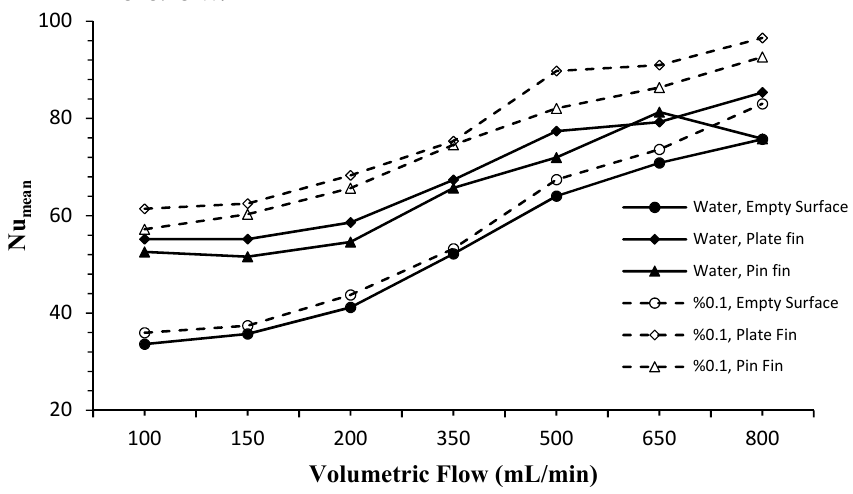
Figure 8. Variation of the mean Nusselt numbers with volumetric flow rates. The variation of the thermal resistance according to volumetric flow rate at 1818.18 W/m 2 is given in Figure 9. As seen in the figure, the highest thermal resistance values were observed at volumetric flow rate of 100 mL/min in the case of the base fluid and the empty surface. When the values that were obtained for the base fluid and nanofluid were compared, the thermal resistance values on all the surfaces were higher in the base fluid. In addition, a decrease in the thermal resistance was observed with increasing volumetric flow rate for all cases. While this drop in thermal resistance occurred faster at low volumetric flow rates, on the contrary it was slower at high values.